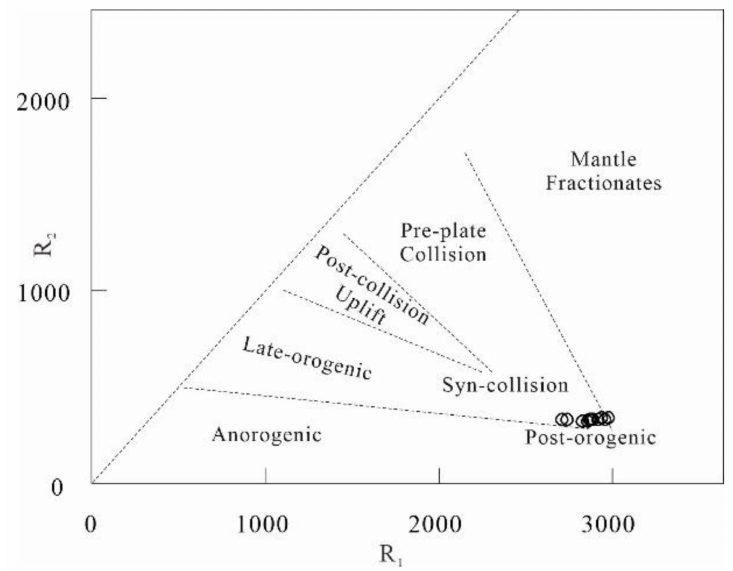
Figure 15. R1-R2 diagram of major granitoid associations of in an orogenic